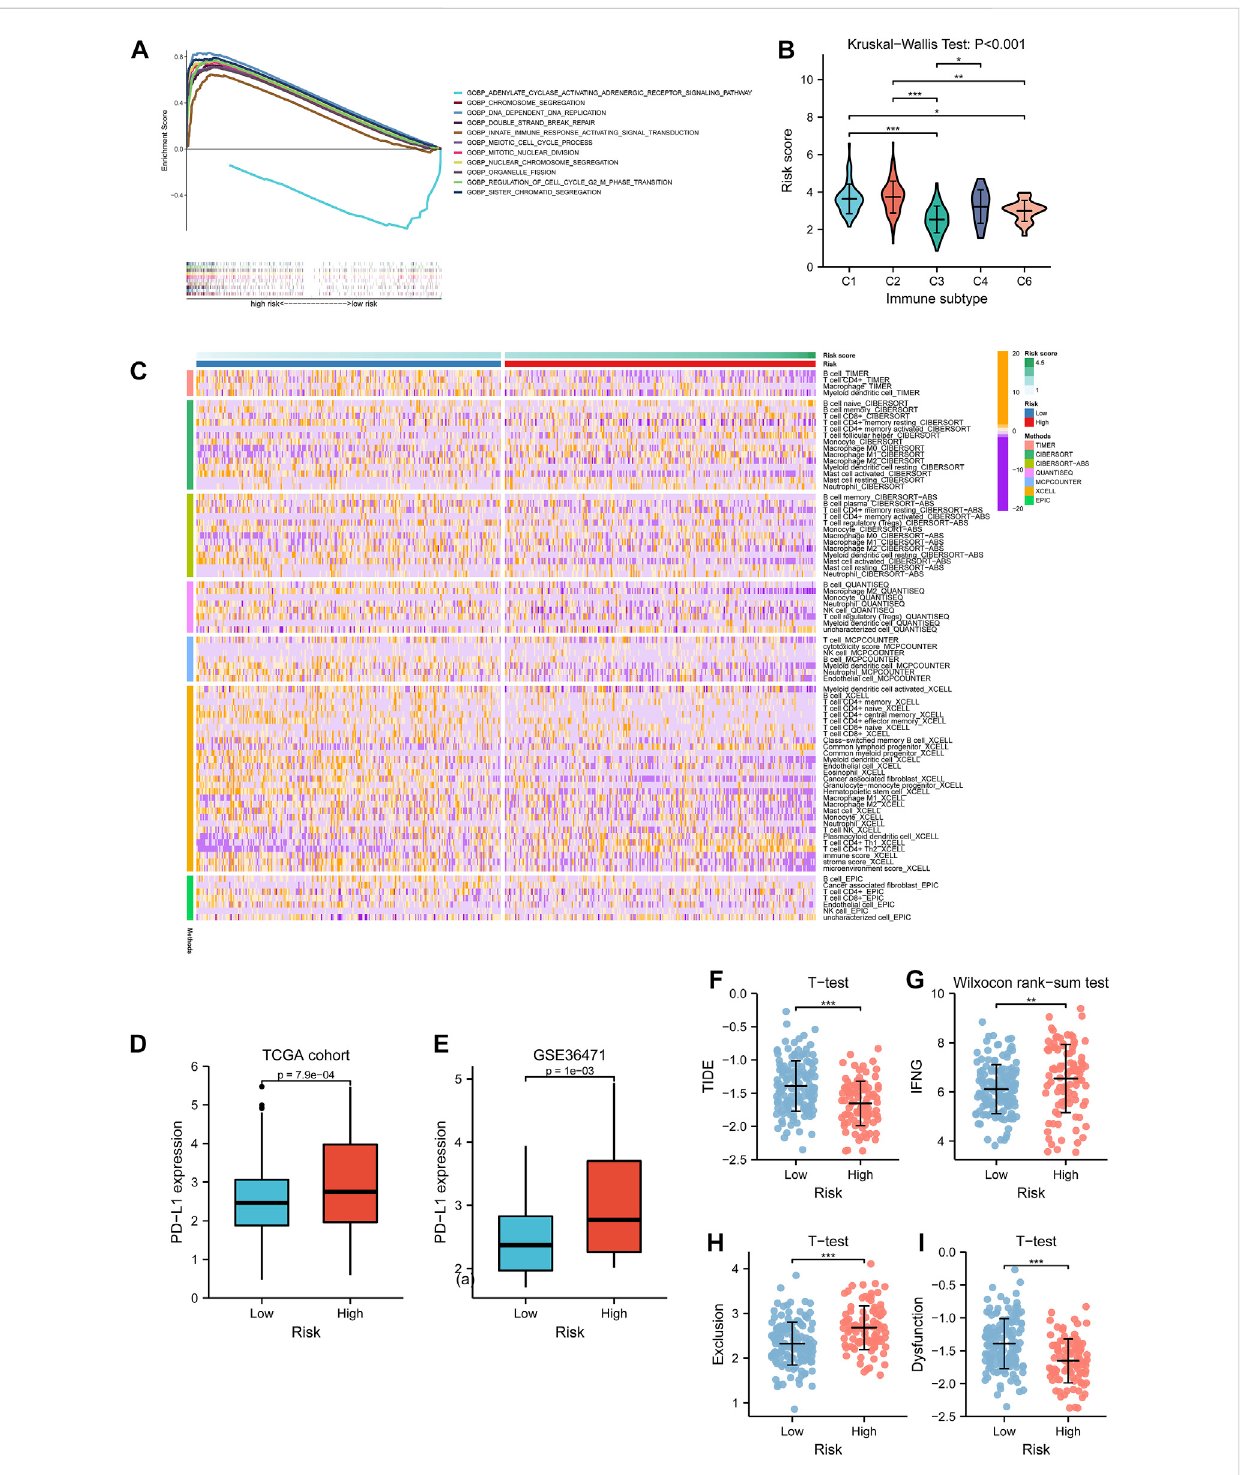
FIGURE 9 Tumorimmune microenvironmentinvestigation. (A) Biologicalfunctionalanalysis ofbiologicalprocesses fortherisksubtypes.The curvesuponthe horizontalaxisrepresentedtermsenrichinginthehigh-riskgroup,whilethecurvebeneaththehorizontalaxisrepresentedtermsenrichinginthelow-risk group. Stripes below showed the gene abundance of each function annotation. (B) Differences of risk score among fi ve immune subtypes in lung adenocarcinoma. (C) Associationsofimmune-in fi ltratinglevelsofdistinctivecelltypescalculatedbyseveralmethodsandriskscoresareshownbya heatmap. (D, E) PD-L1 expression variations between the low- and high-risk group in TCGA cohort and GSE36471. (F – I) Relationships between TIDE score, IFNG score, T-cell exclusion score, T-cell dysfunction score, and risk subtypes respectively. TCGA: The Cancer Genome